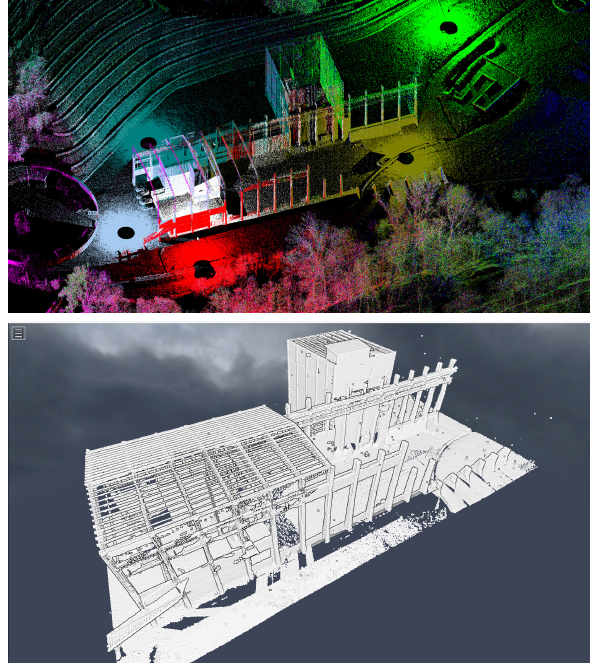
Figure 6. Up: a detail of the scans acquired with Laser Scanner Riegl Vz-4000 of the cement plant building. Down: the final unique point cloud of the building visualized with Potree on the DACD-SUPSI Tokyo